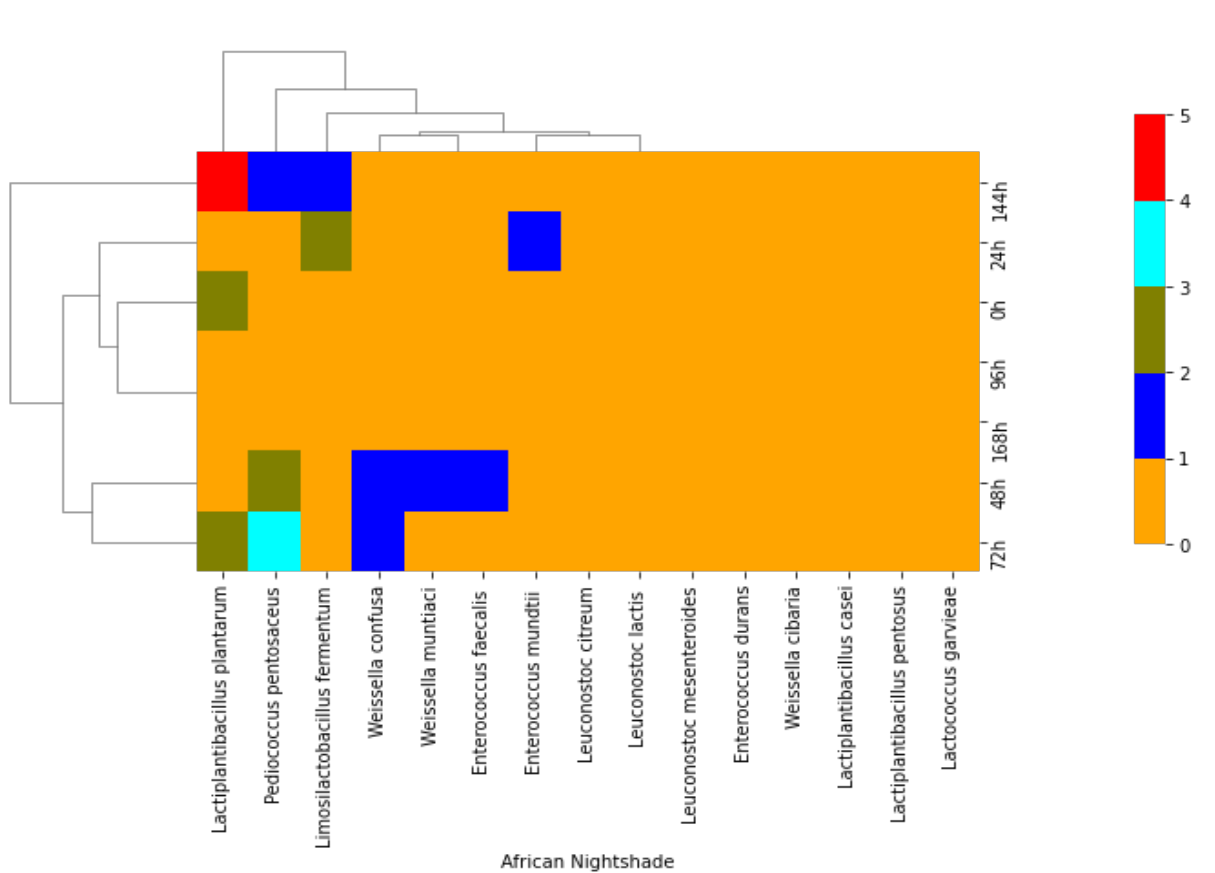
Figure 6. Hierarchical clustering of LAB species from fermented African nightshade leaves at different fermentation times. Legend: Hierarchical clustergram generated using the number of bacterial species from African nightshades at different times. The heatmap (Euclidean matric) shows the relationship between selected bacteria species and varied times. The colored scale bar indicates the significant quantified strength of the various times. The red color in the heatmap indicates the highest, and orange indicates the lowest significance at p ≤ 0.05 for the assayed treatments.